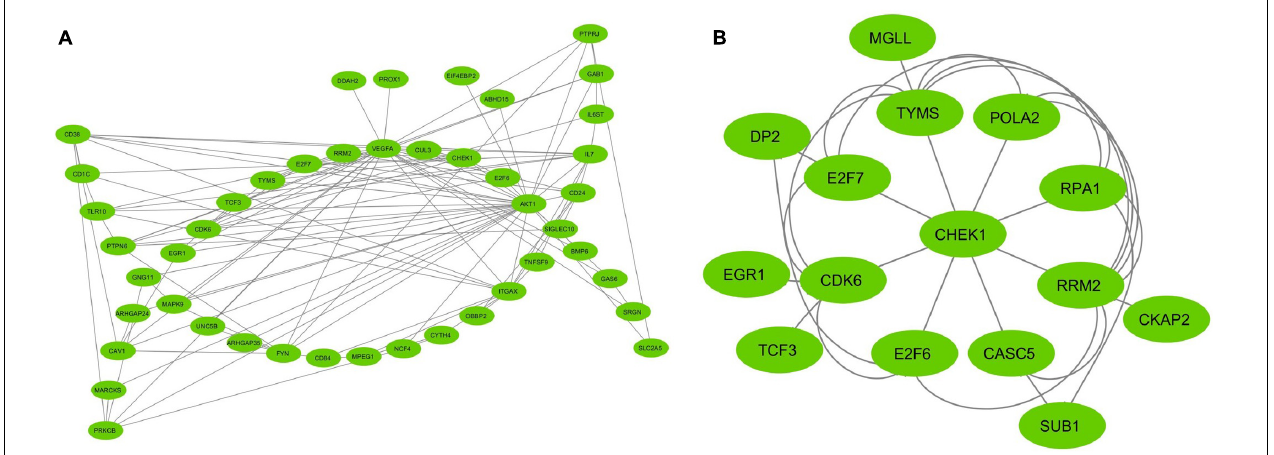
FIGURE 3 | The MCODE (Molecular Complex Detection) plugin from Cytoscape analyzed the top two clusters derived from the network of interactions between protein and protein. (A) Cluster 1; (B) Cluster 2. The MCODE cluster score > 3. The nodes represented as ellipse (green) and edges as lines (gray).